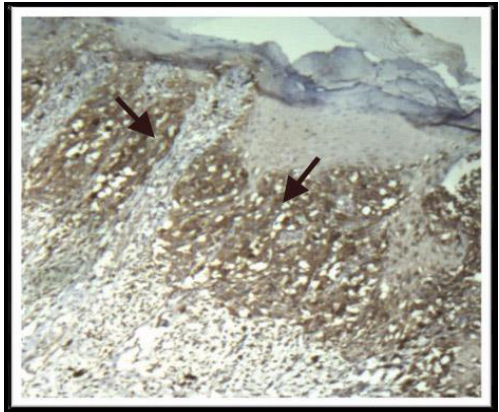
Figure 1. A case of superficial spreading melanoma with H&E staining at X400 magnification.